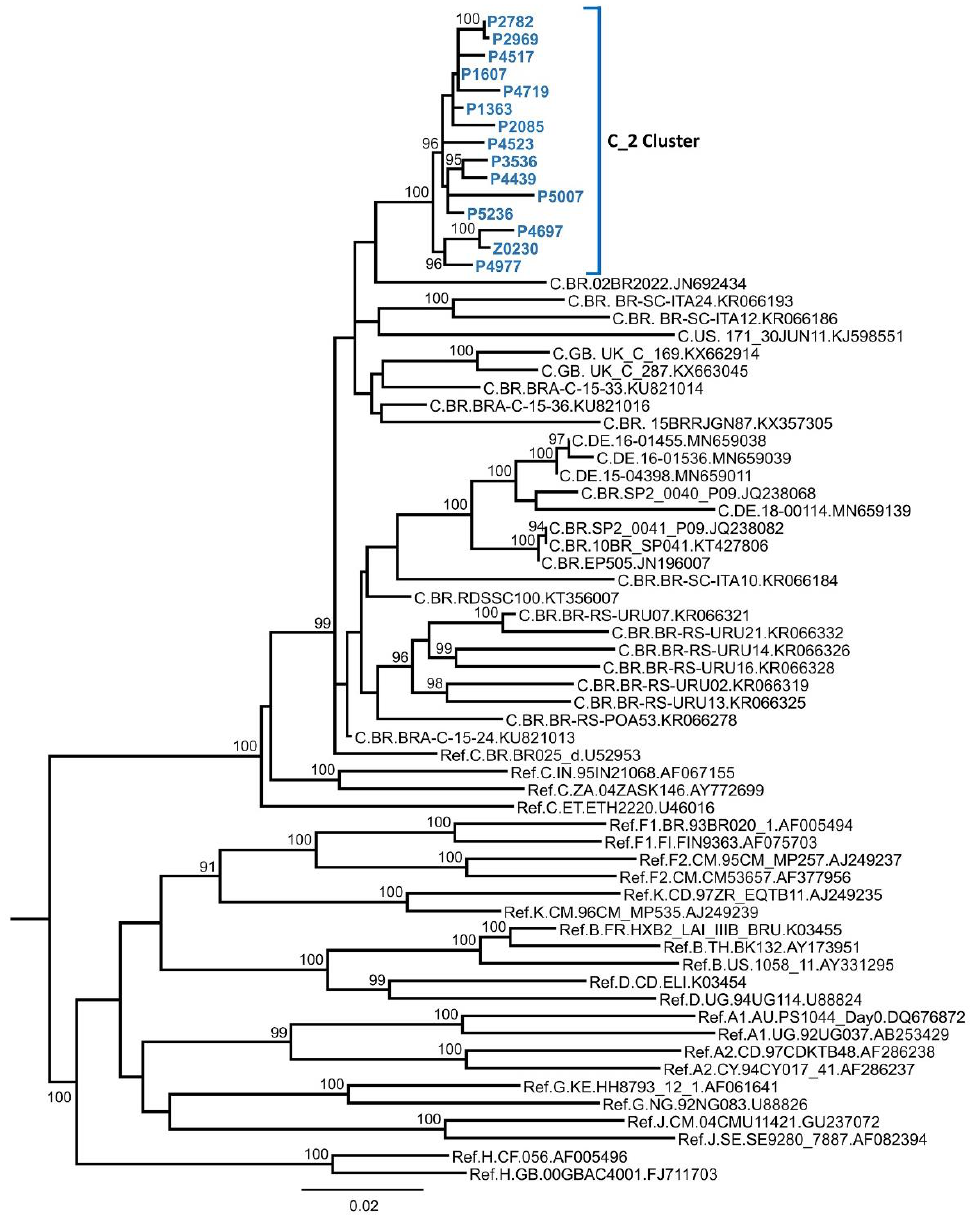
Figure 1. Maximum likelihood tree of C_2 cluster. Similar sequences retrieved from databases and subtype references are also included. Only bootstrap values ≥90% are shown. Sequences obtained in our laboratory are in blue and bold type. Database sequences are labeled with subtype, two-letter ISO code of the country of collection, virus names, and GenBank accession. Subtype reference sequences are labeled with “Ref.”.